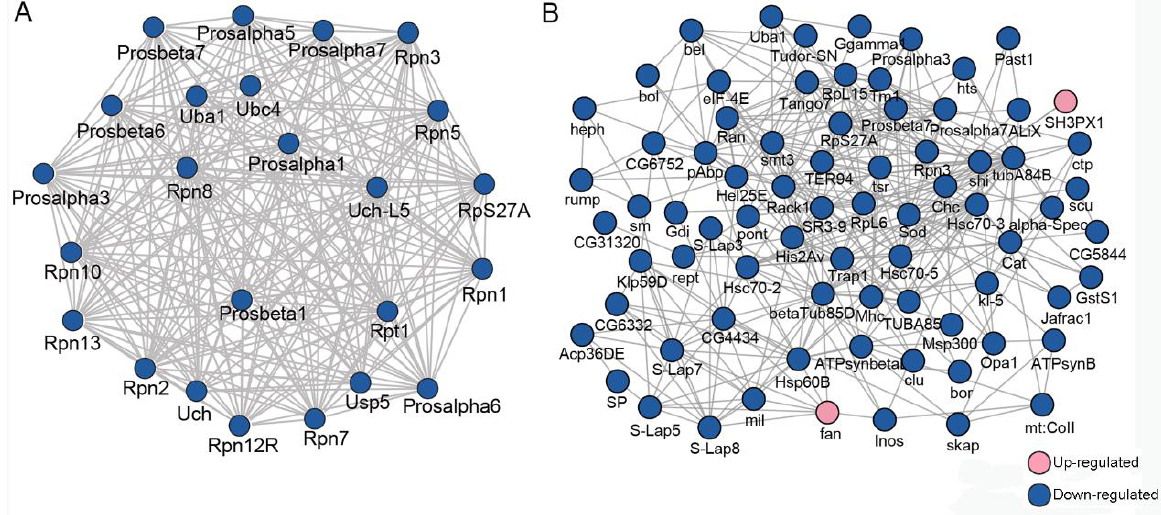
Figure 5. PPI analyses of DEUPs. ( A ) PPI analyses of DEUPs that were involved in the ubiquitin – proteasome pathway. ( B ) PPI analyses of DEUPs that were associated with male